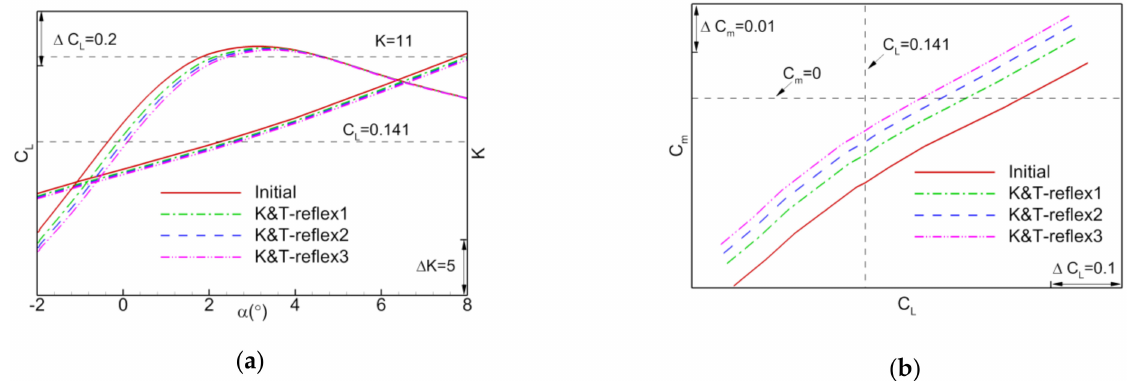
Figure 26. Aerodynamic characteristic of the configurations with different aft-reflexing kink and tip airfoils. Ma = 0.85, H = 11 km, α = − 2 ◦ ∼ 8 ◦ , ∆ α = 2 ◦ . ( a ) Lift coefficient, lift to drag ratio; ( b ) pitching moment.